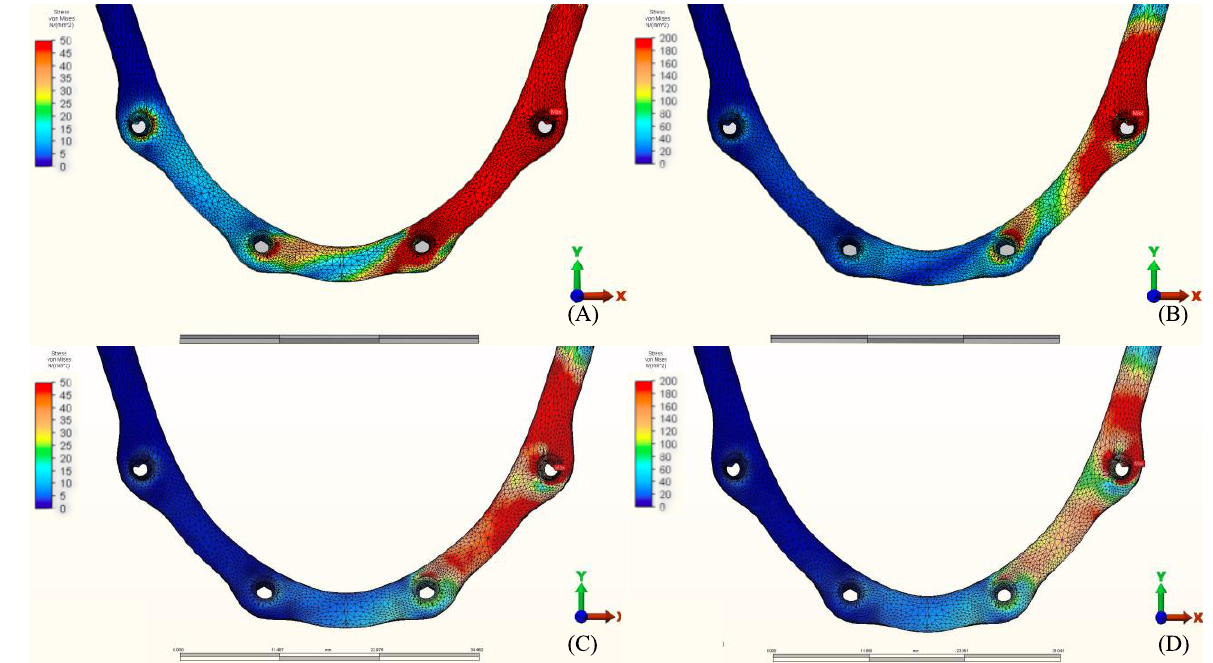
Figure 17. Stress distribution in the framework for group 1, titanium bar with acrylic teeth. ( A ) Model 1.1, opposing natural tooth. ( B ) Model 1.2, opposing tooth-supported full ceramic crown. ( C ) Model 1.3, opposing acrylic prosthesis with titanium framework. ( D ) Model 1.4, opposing implant-supported full ceramic crown.